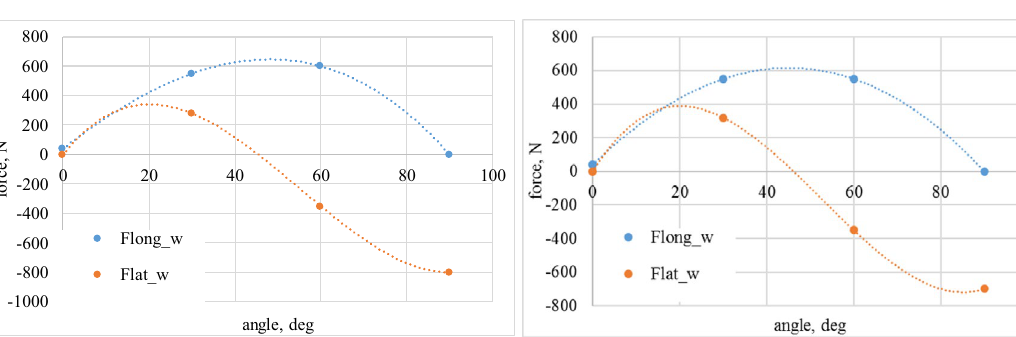
Figure 11. Values of longitudinal and lateral forces depending of the slip (attack) angle—dry granite.